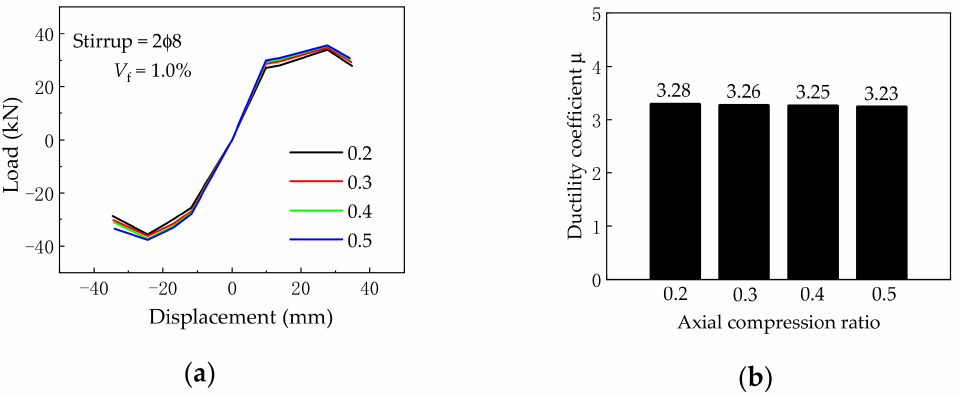
Figure 18. ( a ) Skeleton curves and ( b ) ductility coefficient under different axial compression